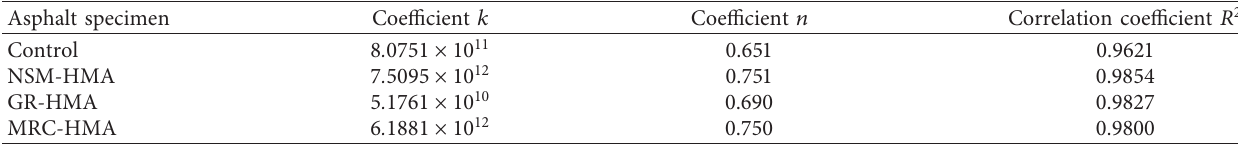
Table 8: Fatigue equations’